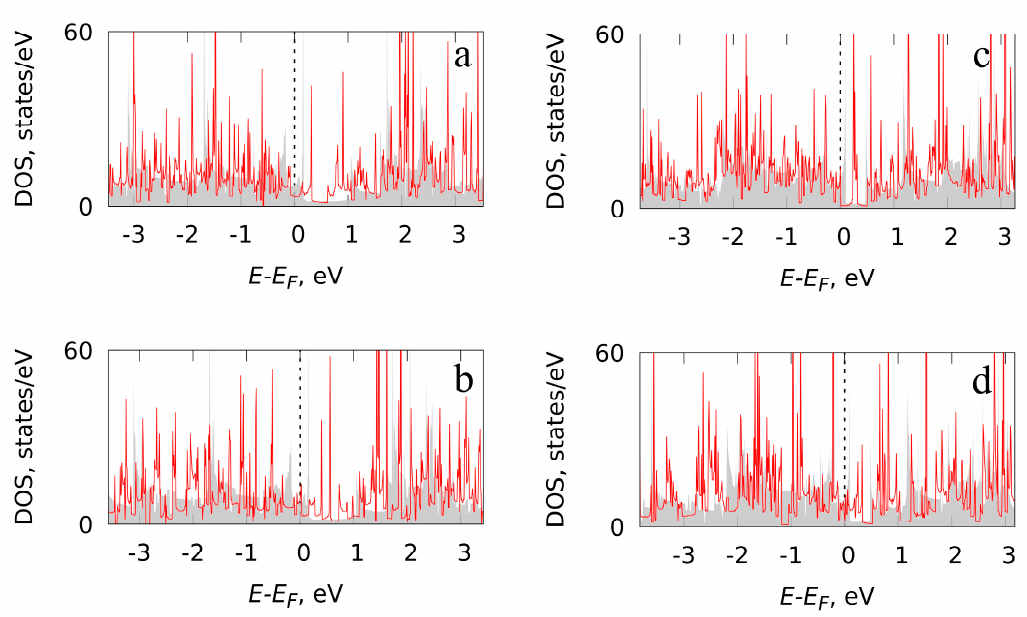
Figure 2. Density of electronic states for ( a ) B-doped ( b ) and C-doped Si 5 -polyprismane; ( c ) B-doped ( d ) and C-doped Si 6 -polyprismane (red line). The gray filled area corresponds to the unsubstituted Si 5 and Si 6 -polyprismanes.